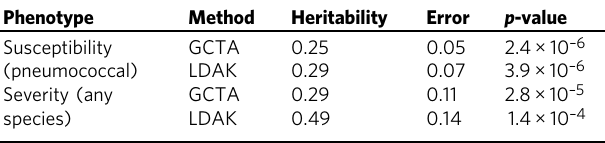
Table 4 Human SNP heritability ( h 2 SNP ) of meningitis in the MeninGene cohort